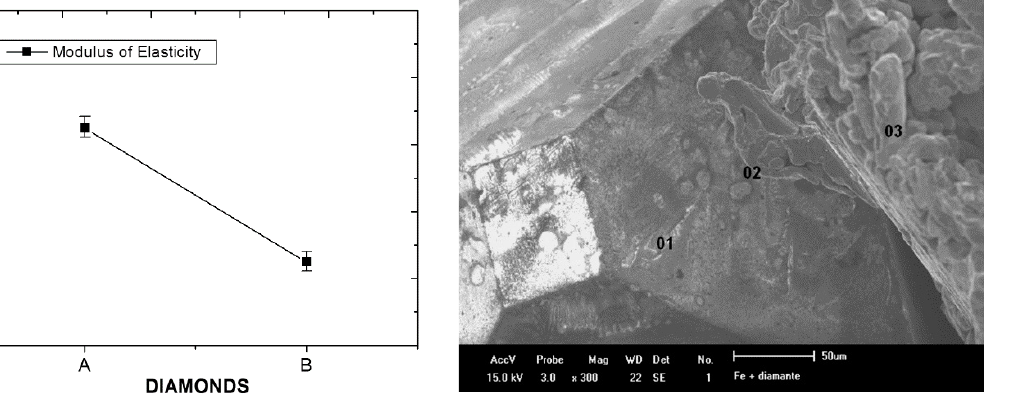
Figure 10. Micrograph of Fe-uncoated diamond composite after compression test. Points 1 to 3 are regarded to EDS analyses.